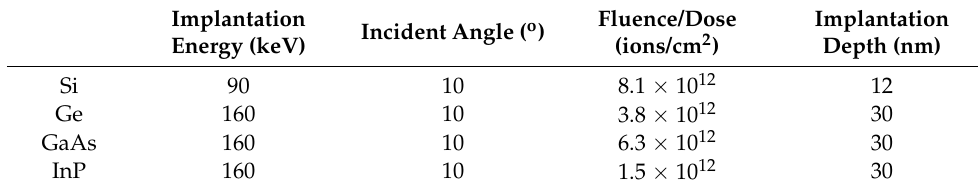
Table 1. Detailed parameters of implantation